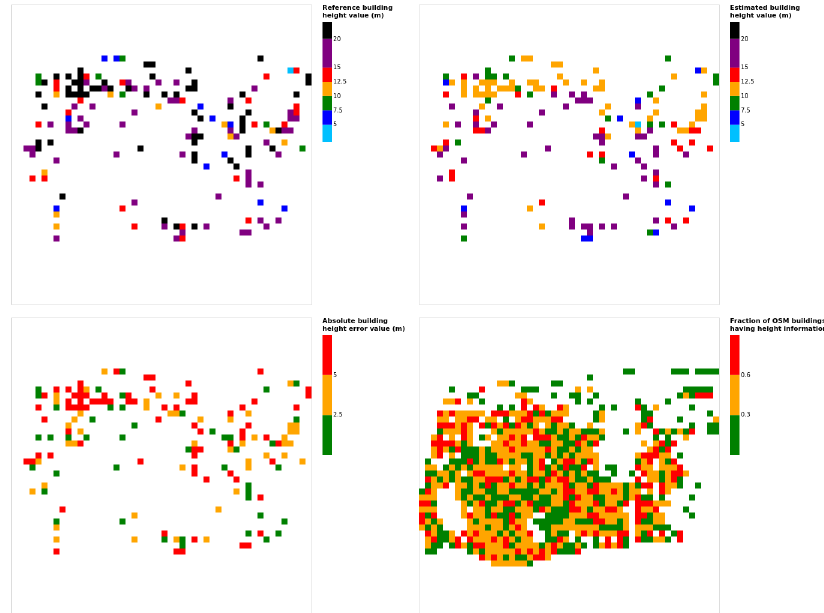
Figure B17. Results for the commune at grid cell (upper left panel) reference building height, (upper right panel) estimated building height, (lower left panel) absolute building height error, and (lower right panel) fraction of OSM buildings that have height information. For all panels except the lower right, only cells that have buildings – with at least 90% of their buildings having no height value in OSM – are displayed.